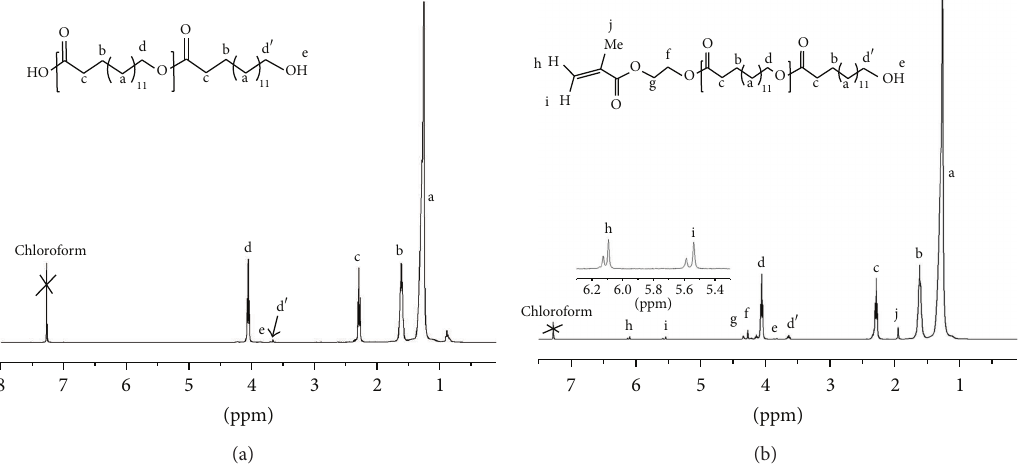
Figure 6: 1 H NMR spectra: (a)—polyPDL; (b)—polyPDL obtained in presence of HEMA.